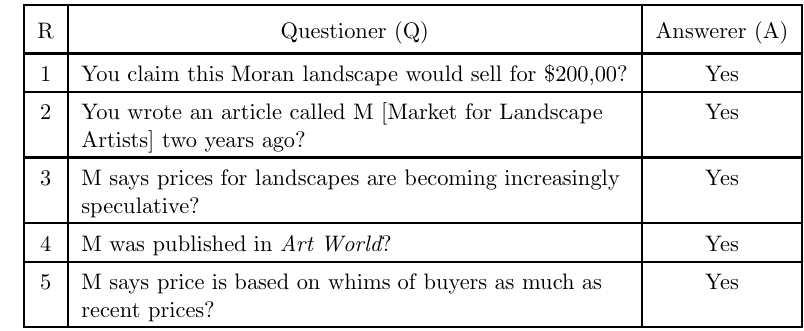
Dialogue for the Landscape